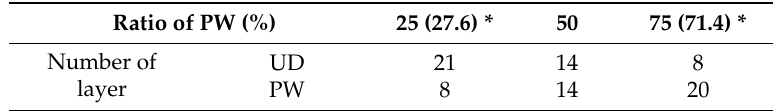
Table 2. Detail composition of the multi-layered preforms with varying ratio of PW fabric. *(FAW) Fiber Areal